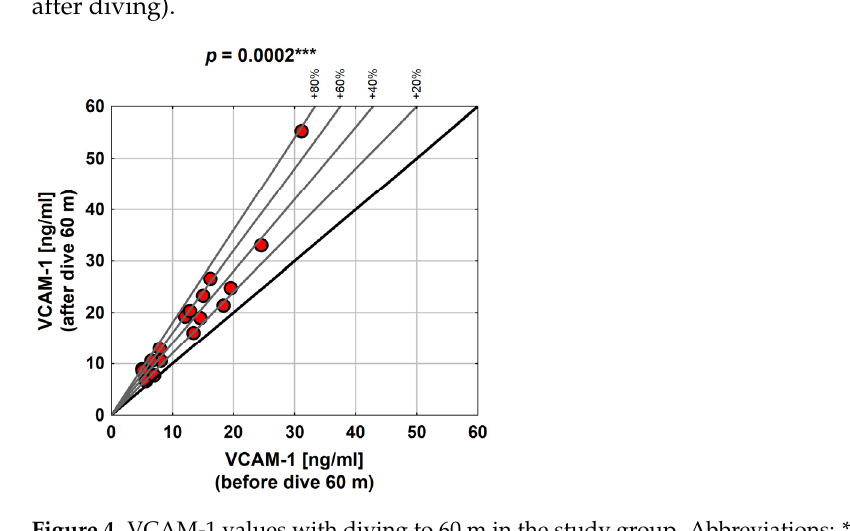
Figure 4. VCAM-1 values with diving to 60 m in the study group. Abbreviations: ***— p < 0.001.